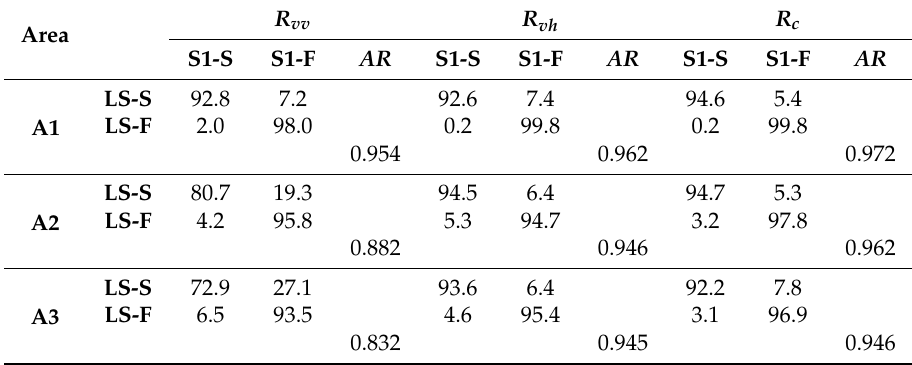
Figure 5. Snow map of Swiss Alps (Berne, Valais). ( Top ) Snow extent (blue) derived from Landsat-7 image of 3 June 2015; background: Landsat ETM+ bands 5, 4, 3; yellow: clouds; white: water. ( Bottom ) Snow extent (blue) derived from Sentinel-1 image of 7 June 2015; background: amplitude image, VV -channel; orange: mask for layover and foreshortening. Table 4. Confusion matrix for the classes snow (S) and snow-free (F) in the 3 study areas, for snow classification based on Landsat (LS) and Sentinel-1 (S1) data. S1 results are shown for snow maps based on the ratios R vv , R vh , and R c . AR —overall agreement rate (0.0 ď AR ď 1.0 ).